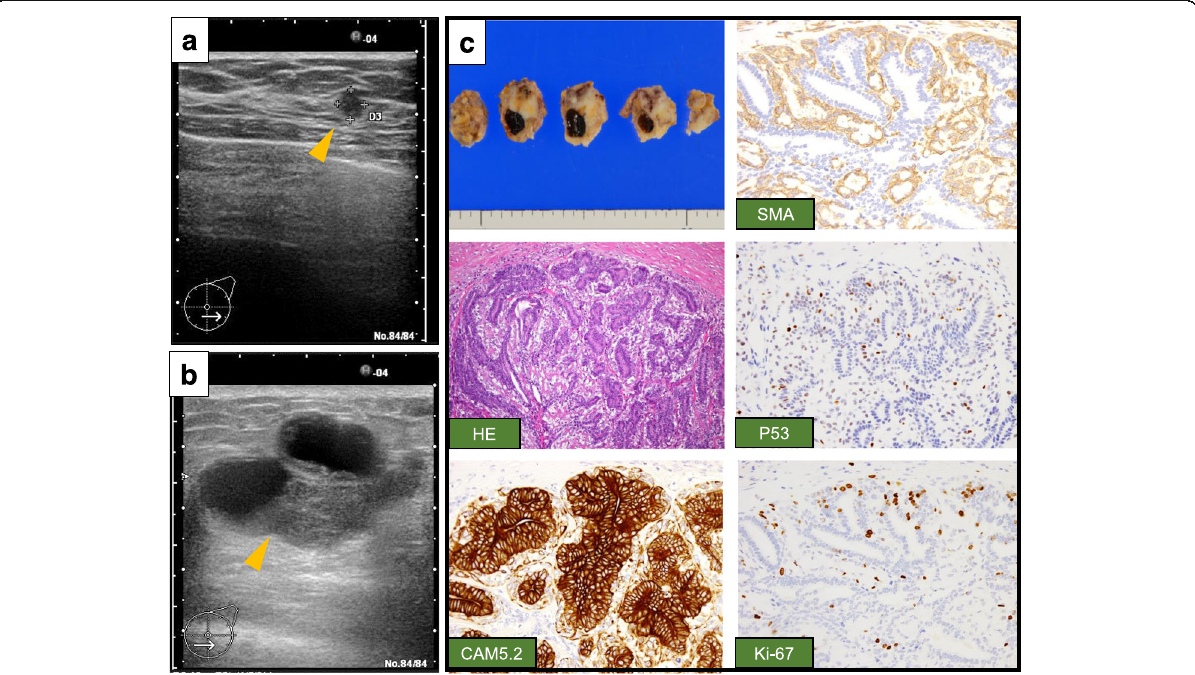
Fig. 1 Ultrasonographic examination from the first consultation to the primary operation. a An ultrasonography (US) scan of the breast demonstrated a low-density area measuring 4.9 × 5.1 × 4.2 mm (orange arrowhead). b An US scan of the breast demonstrated a low-density area measuring 26.1 × 22.6 × 26.8 mm (orange arrowhead). c Histopathological findings of the tumor at the primary operation. Although mitotic figures were present slightly, there was no proliferative lesion or ductal invasion. The tumor was consisted of both epithelial cells, which was positive for CAM 5.2, and myoepithelial cells, which was strongly positive for α -smooth muscle actin (SMA). Ki-67 labeling index (Ki-67) and P53 were weakly positive. ×